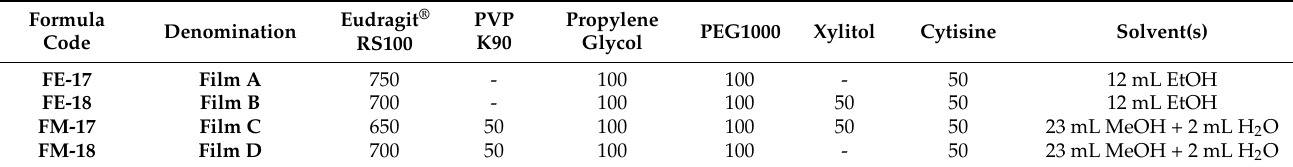
Table 3. Weight composition (mg) and denomination of the best resulting CYT-loaded buccal films.